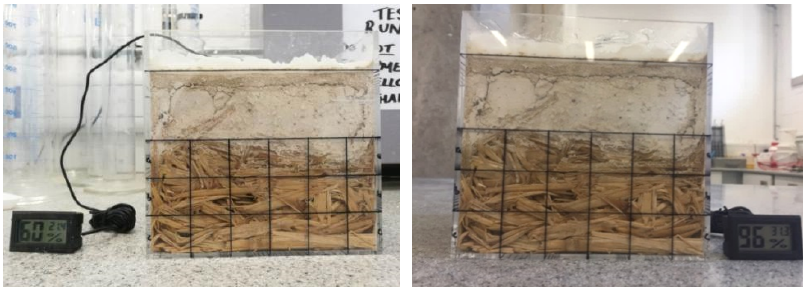
Figure 7. Specimen of rice straw with parallel placing before the degradation research ( left ) and after 12 weeks in climatic chamber ( right ).